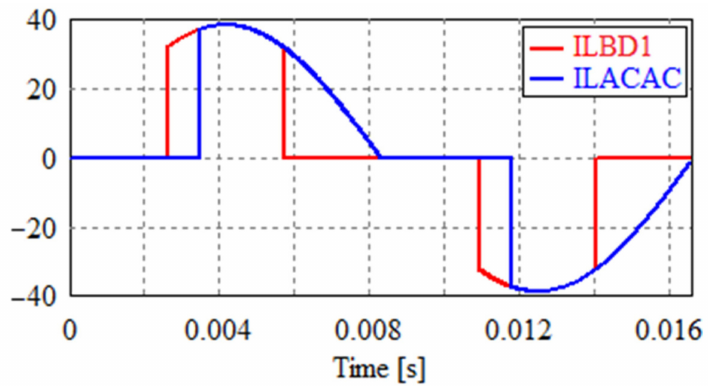
Figure 3. Phase current (blue: alternating current–alternating current (AC-AC) converter; red: rectifier and symmetrical